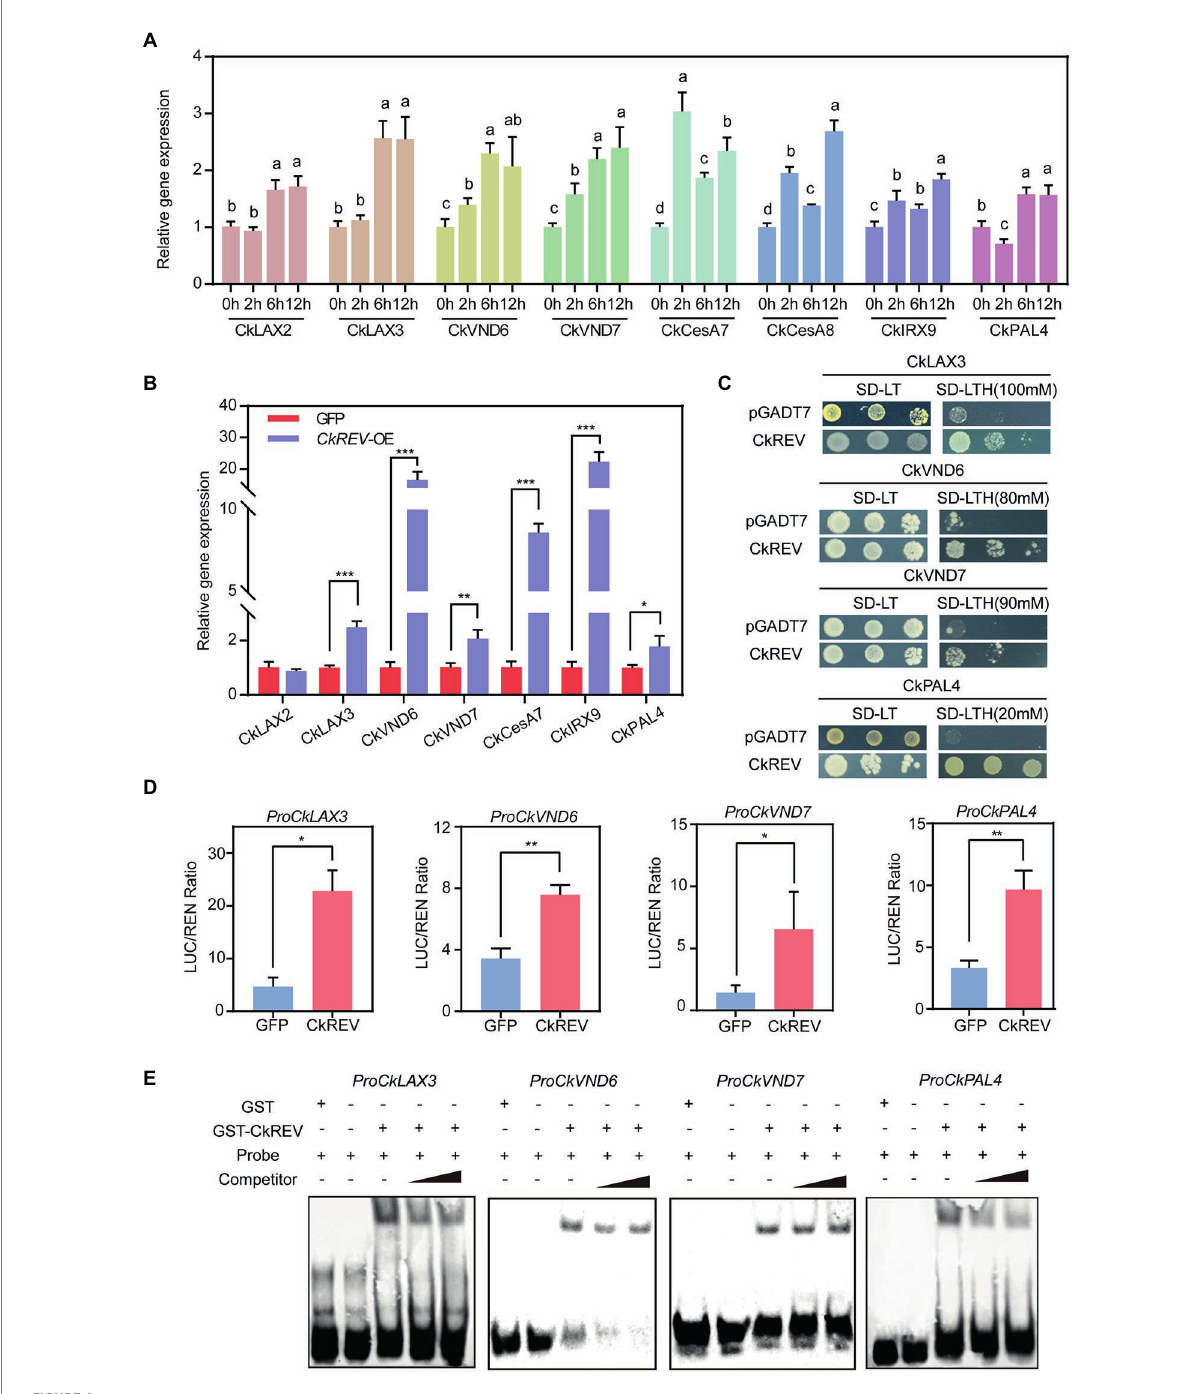
FIGURE 4 CkREV directly regulates the expression of CkLAX3 , CkVND6 , CkVND7 , and CkPAL4 to promote secondary development of vessels. (A) qRT-PCR analysis on the level of genes concerning polar auxin transport, vessel differentiation, and the synthesis of cellulose, xylan, and lignin after PEG-simulated drought treatment for corresponding durations on hydroponic C. korshinskii seedlings. (B) Expression levels of genes related to polar auxin transport, vessel differentiation, cellulose, xylan, and lignin synthesis in CkREV overexpressed C. korshinskii leaves. (C) The regulation of CkREV on CkLAX3 , CkVND6 , CkVND7 , and CkPAL4 tested by Y1H. (D) The regulation of CkREV on CkLAX3 , CkVND6 , CkVND7 , and CkPAL4 tested by Dual-LUC. (E) The regulation of CkREV on CkLAX3 , CkVND6 , CkVND7 , and CkPAL4 tested by EMSA. Error bars indicate SD ( n = 3). (A) One-way ANOVA is performed for the statistical analysis, where different letters represent significant differences ( p < 0.05). (B,D) Student’s t -test is employed to measure statistical significance between two samples with confidence level at 0.95 (* p < 0.05; ** p < 0.01; and *** p <